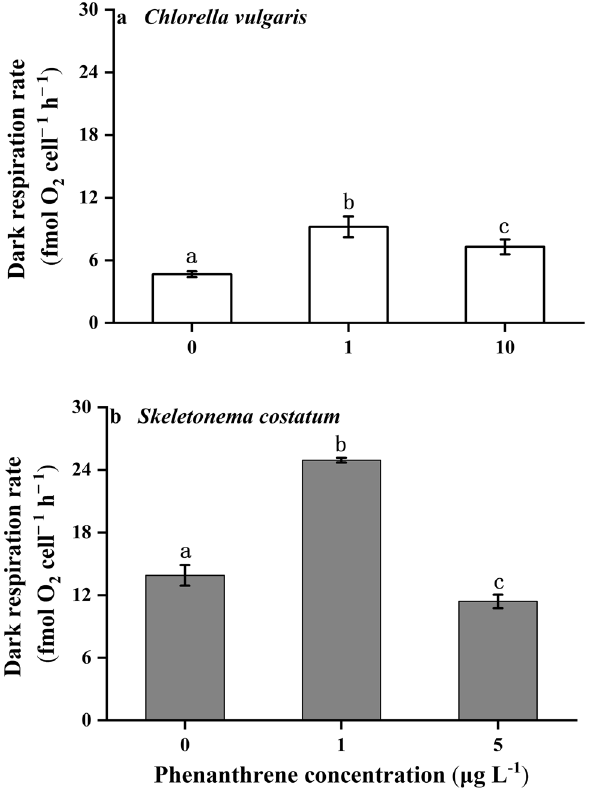
Figure 5. The dark respiration rates of Chlorella vulgaris (a) and Skeletonema costatum (b) cells at different phenanthrene concentrations. The data are means ± SD of triplicate cultures (n = 3). The different lowercase letters indicate significant ( p < 0.05) differences between phenanthrene concentrations in one species (one-way ANOVA and post-hoc Tukey